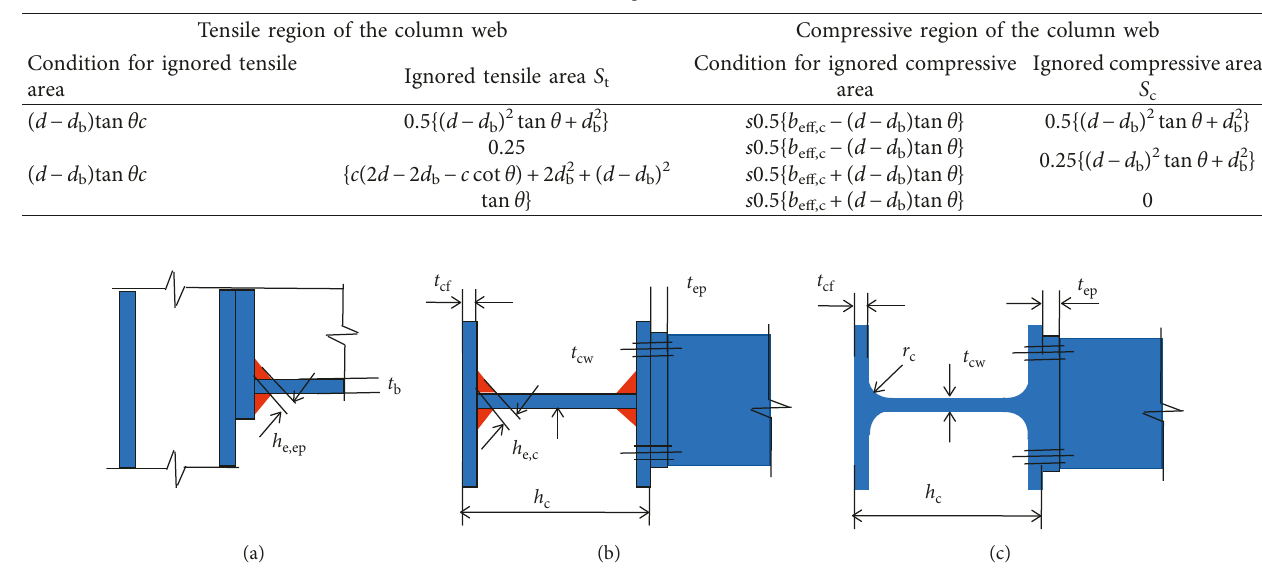
Table 9: Calculation of the ignored area of the column web.